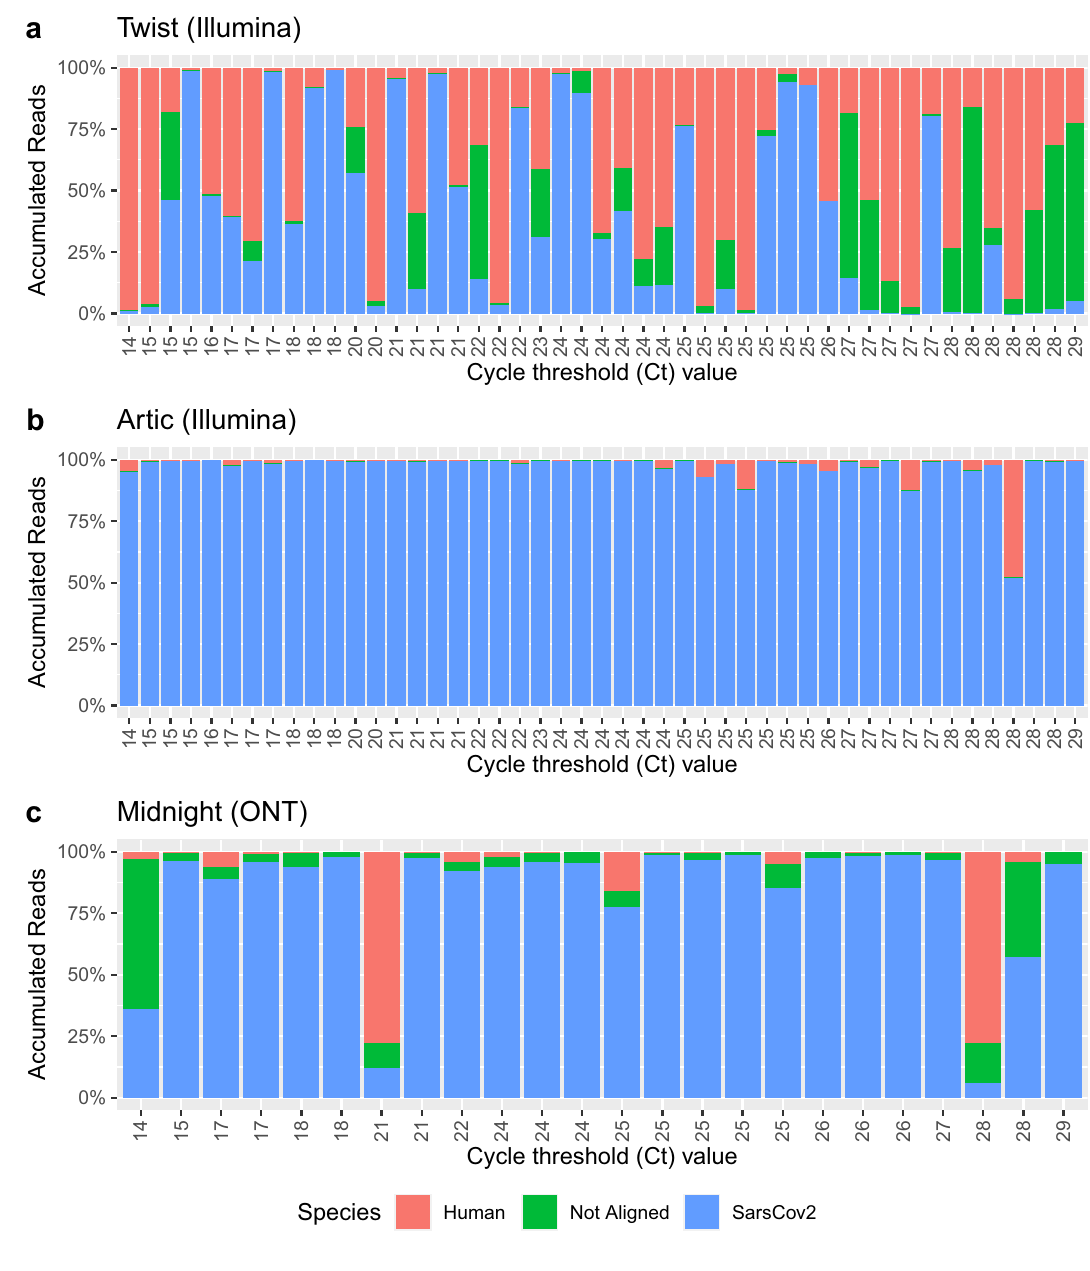
Figure 4. Human host content. Cycle threshold value versus number of raw reads in per cent mapped to hg19, SARS‑CoV‑2, or unaligned, using ( a ) Twist bait hybridization enrichment (n = 47), ( b ) ARTIC V3 tiled amplicon enrichment (n = 47), ( c ) Midnight tiled amplicon enrichment (n =